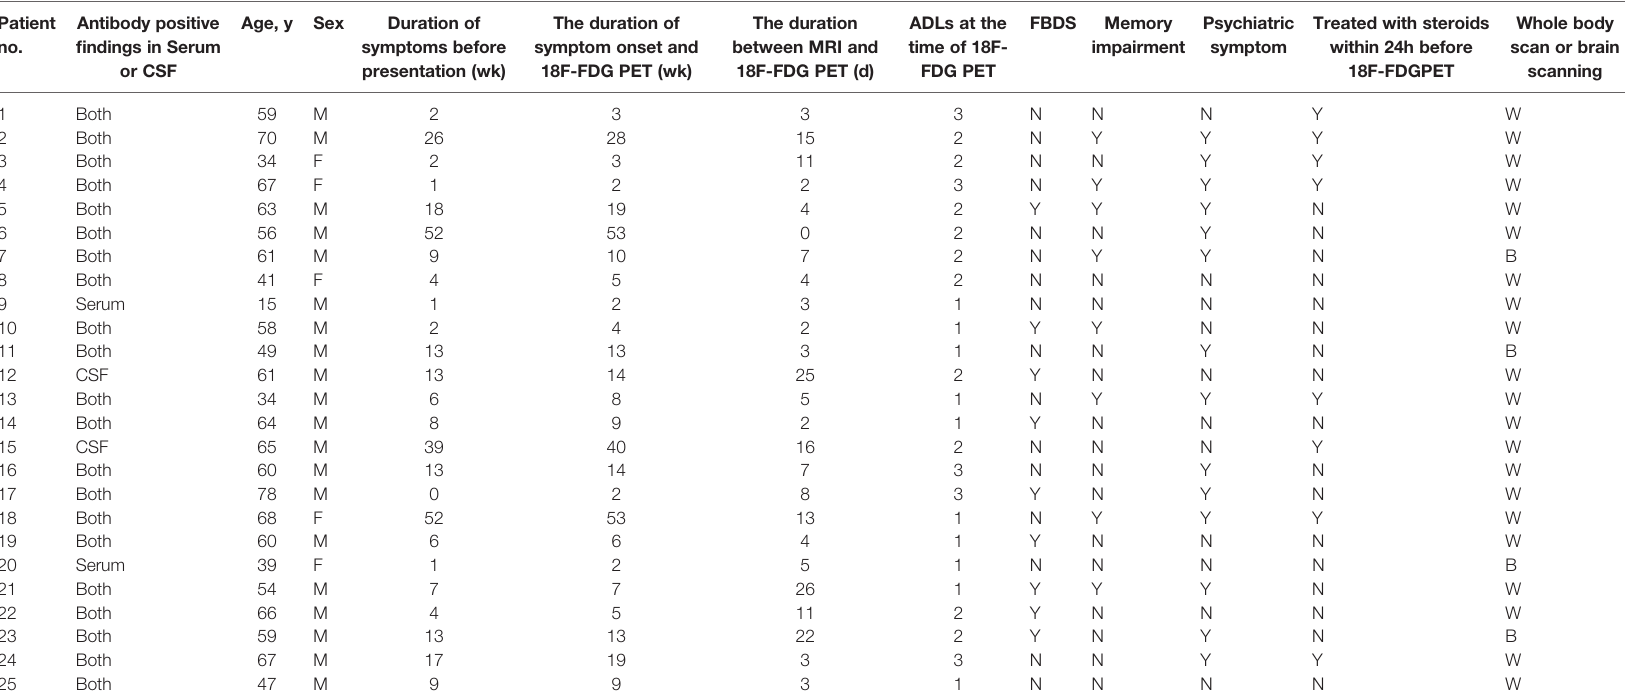
TABLE 1 | Clinical characteristics of the patients included in the study. Patient